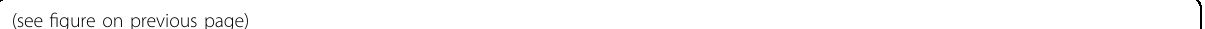
Fig. 4 The function of circUBAP2 in the effects of CAFs-derived CXCL11 on HCC cells and the selection of mRNA related to the functions of circUBAP2. A Silencing of circUBAP2 was achieved in MHCC-97H and Huh-7 cells by transfecting small interfering RNA targeting circUBAP2 (si- circUBAP2-1 or si-circUBAP2-2). Si-NC was transfected as a negative control. The transfection ef fi ciency was con fi rmed by real-time PCR and si- circUBAP2-1 was chosen for further experiments for its better transfection ef fi ciency. Then, MHCC-97H and Huh-7 cells were transfected with si- circUBAP2 and examined for B Cell migration by Transwell assay; C Cell migration by wound healing assay; D The protein levels of Vimentin and Twist was examined by Immunoblotting; E The concentrations of IL-1 β and IL-17 in the culture medium by ELISA. F , G The Volcano plot and hierarchical clustering heatmap showing differentially expressed mRNAs in CXCL11-treated MHCC-97H based on RNA sequencing. Upregulated genes were applied for H Kyoto Encyclopedia of Genes and Genomes (KEGG) signaling enrichment analysis and I Gene Ontology (GO) of biological process enrichment analysis. J The expression of IFIT1/IFIT3 in CXCL11-treated and untreated HCC cells based on RNA sequencing data. * P < 0.05, ** P < 0.01, compared with the control group; # P < 0.05, ## P < 0.01, compared with the si-NC group; $ P < 0.05, $$ P < 0.01, compared with the CXCL11 + si- circUBAP2